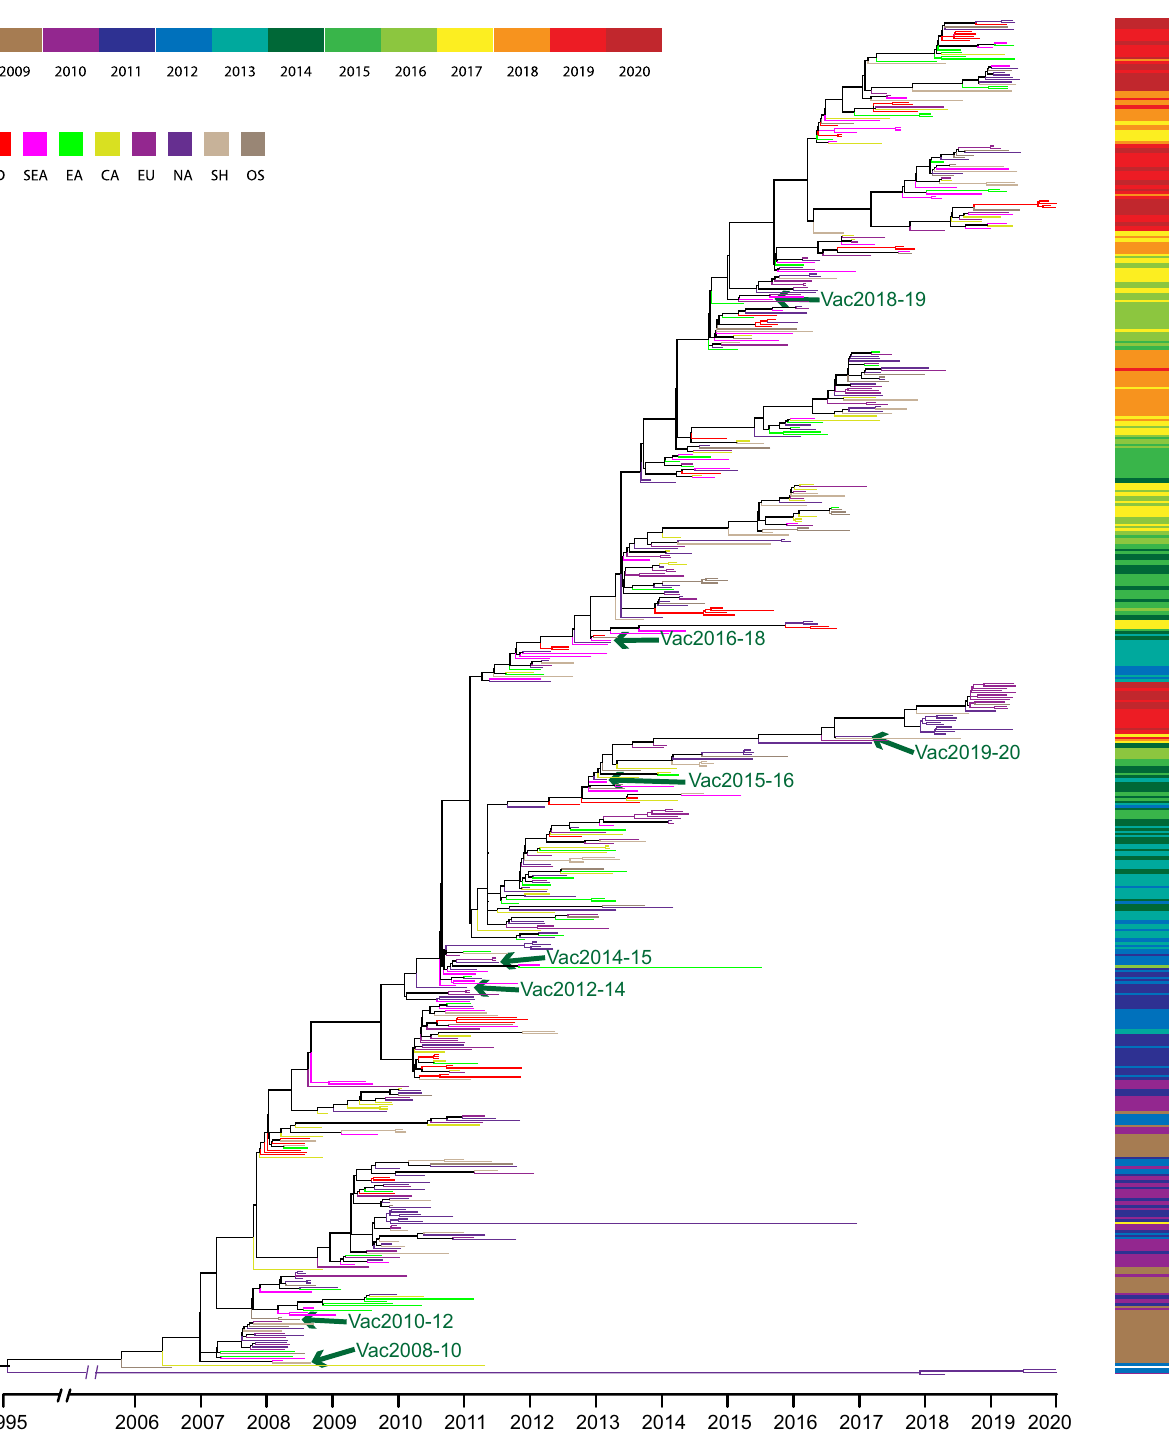
Figure 1. The time-scaled phylogenetic tree of HA gene from globally circulating influenza A subtype H3N2 strains, including WHO-recommended vaccine strains (indicated by green arrow). Different branch colours indicated strains location. The right colour ribbon indicates the year of sample